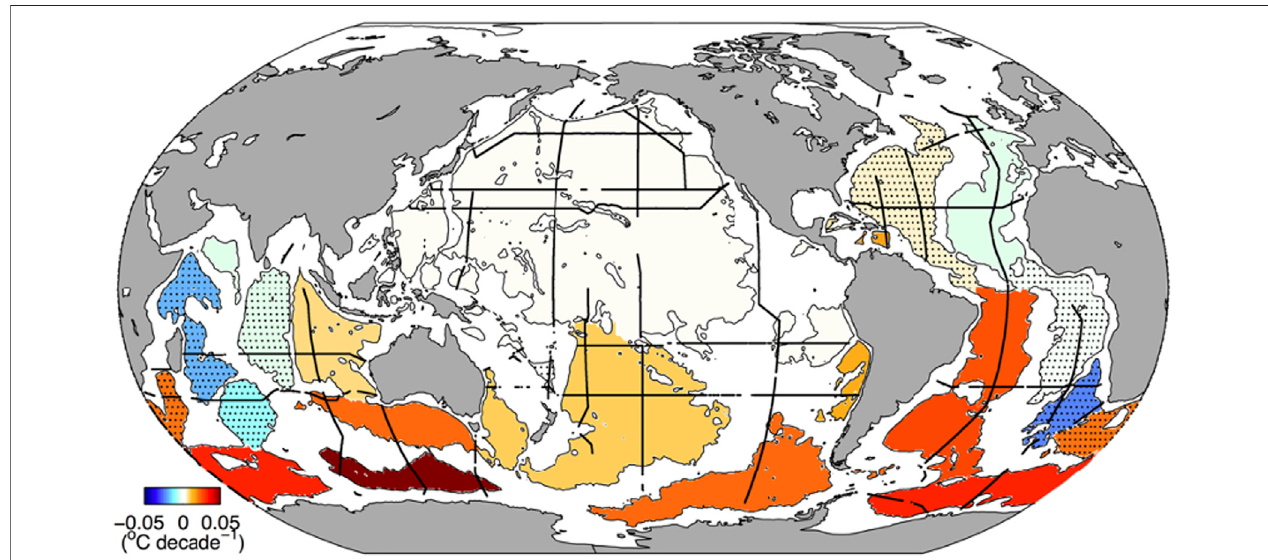
FIGURE6| Deepbasin(thinsolidlines)averagewarmingratesbelow4,000 mfromthe1990stothe2000s( ° Cdecade − 1 ,colorbar)basedondatafromPurkeyand Johnson (2010). Estimates are based on data from decadal repeats of hydrographic sections (thick solid lines) fi rst occupied during the World Ocean Circulation Experiment (WOCE) (King et al., 2001) and subsequently by GO-SHIP (Talley et al., 2016). Stippled basins have average warming rates that are not statistically signi fi cantly different from zero at 95% con fi dence. Permission obtained for use of fi gure.